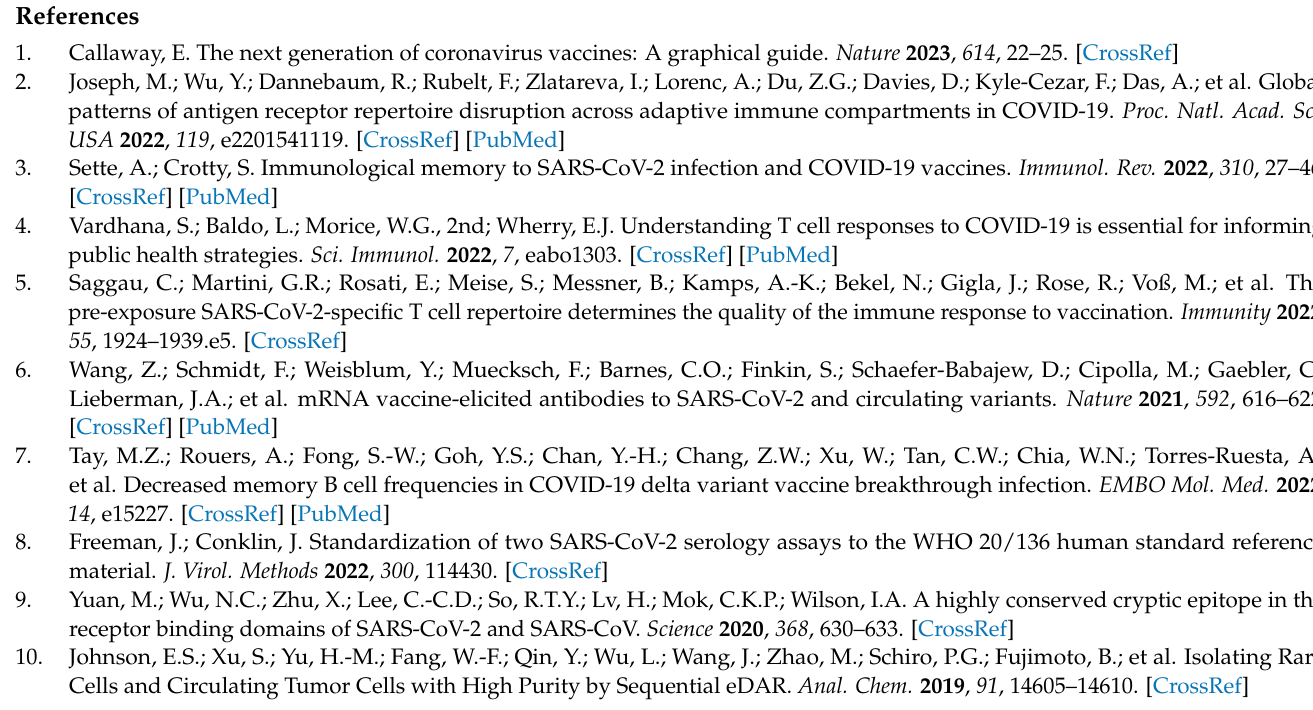
Table S2. Anti-spike-RBD neutralizing antibody validation data by ELISA. Serial dilutions of the First WHO International Standard (20/136) for anti-SARS-CoV-2 immunoglobulin, was measured and used as the standard for the neutralizing ELISA assay. The assay was validated with high titer samples, 20/150, mid-titer samples, 20/148, and negative plasma, 20/142. Table S3. Demographic Information for vaccinated SARS-CoV-2 naïve subjects. Number of participants, age, sex, and vaccine type are indicated. Table S4. Reagents used for ELISA and spike-RBD specific memory B cells detection. Reagent, vendor, catalog number, and concentration/dilution are